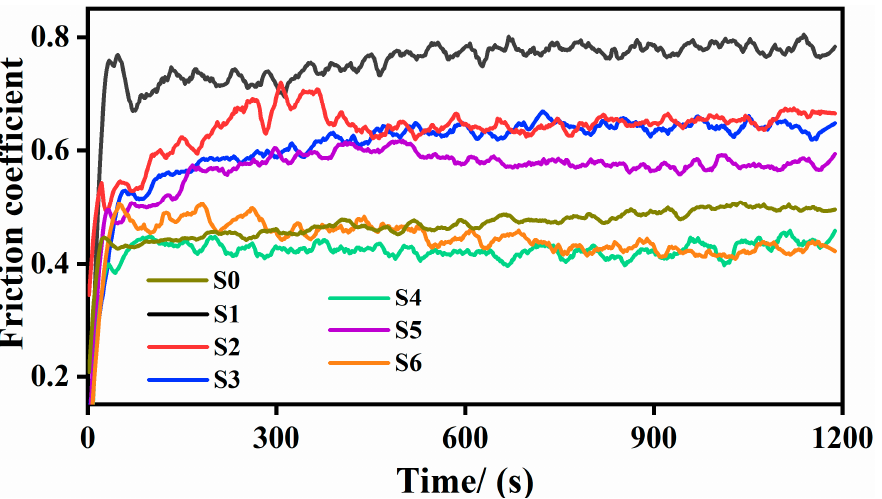
Figure 9. Friction coefficient curves of composite coating with different ceramic micro-particles.